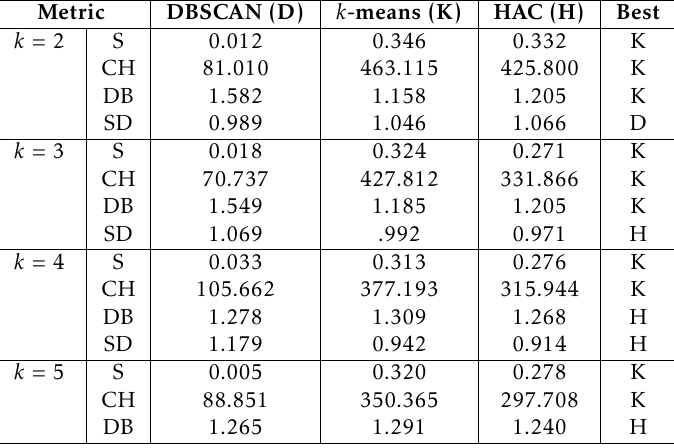
Table C.4. Performance of user clustering (Dataset MI